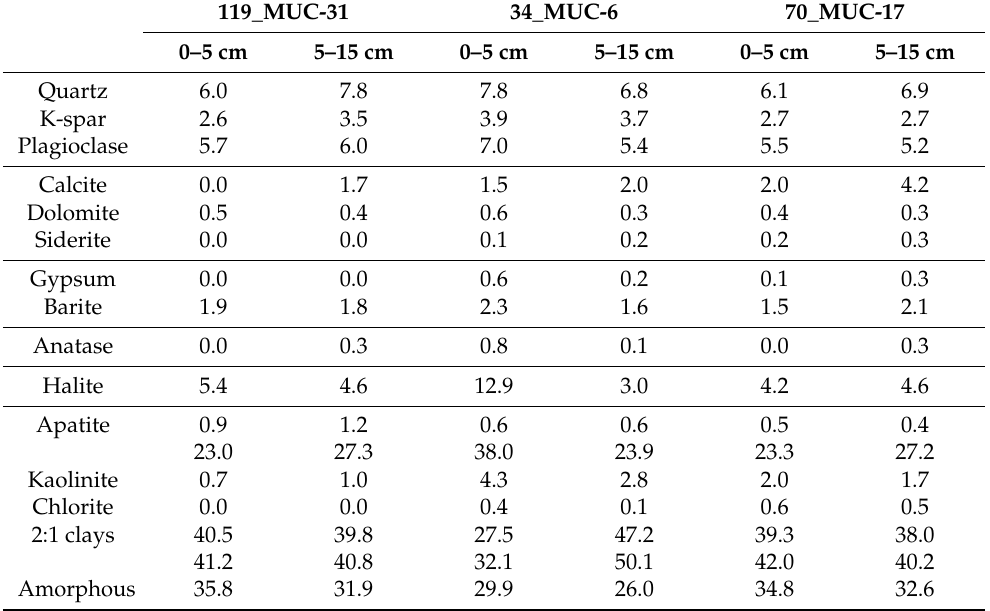
Table A1. Quantitative bulk mineralogical compositions of the samples in weight percentages